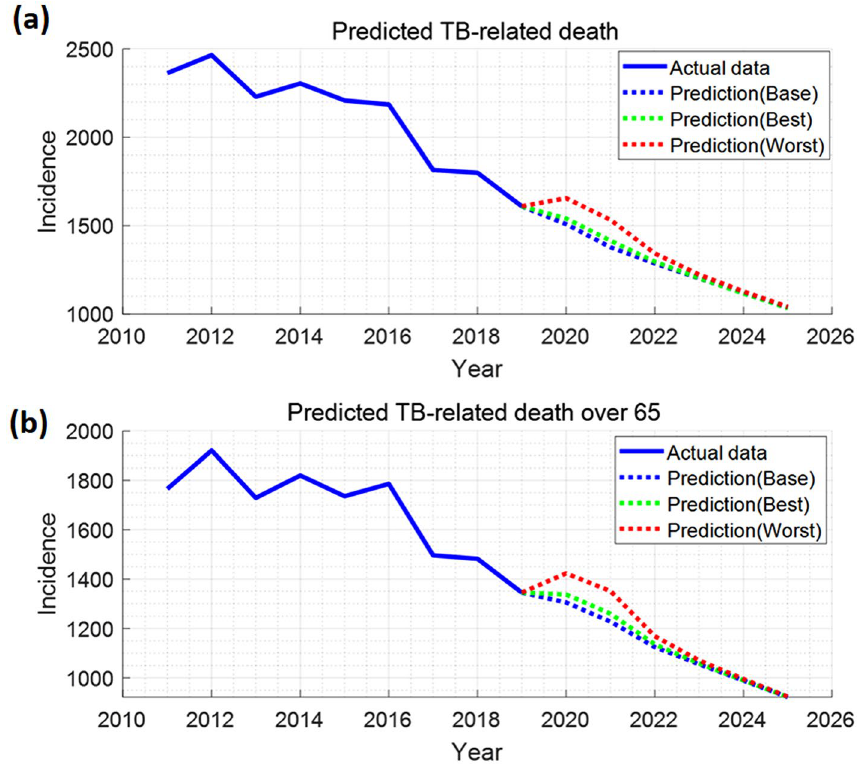
Figure 5. Number of TB-related deaths in all age groups ( a ) and > 65 ( b ): data through 2019 and model forecasts for 2020–2025 under different scenarios of social distancing and health service disruption.